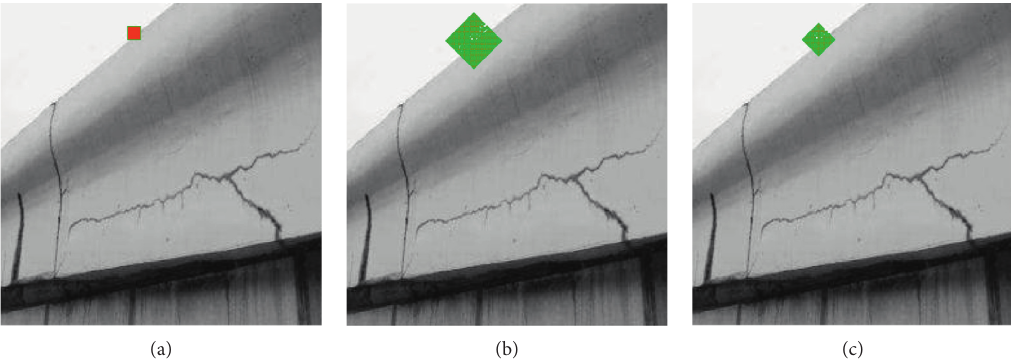
Figure 8: Percolation regions of pixel (20, 100) in image crack 3: (a) raw image; (b) without termination; (c) with termination.